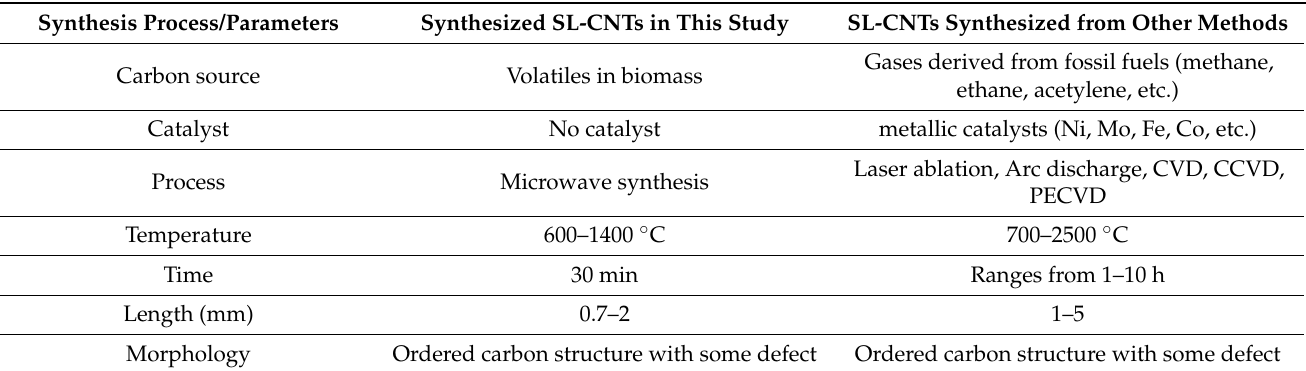
Table 4. Comparison between the SL-CNTs synthesized in this study and literature